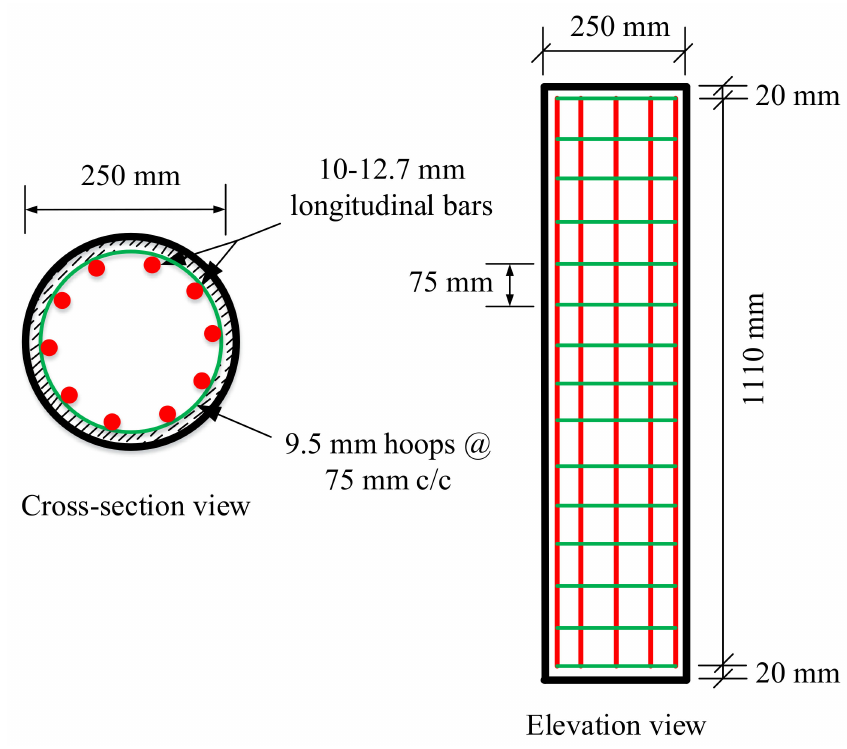
Figure 3. Schematic diagram of a specimen with 75 mm pitch of GFRP hoops. The compressive members were labeled using two digits and five letters. The first letter “G” indicates GFRP reinforcement, the second letter “G” indicates geopolymer concrete, “RAC” represents recycled aggregate concrete, the last digit designates the number of longitudinal GFRP bars, and the right-hand side digit represents the spacing of transverse GFRP hoops. For example, GGRAC8-250 is a GGRAC column that contains six GFRP longitudinal bars and GFRP lateral hoops at a clear spacing of 250 mm. Table 4 reports the geometric and testing particulars of the compressive members. Five mm thick